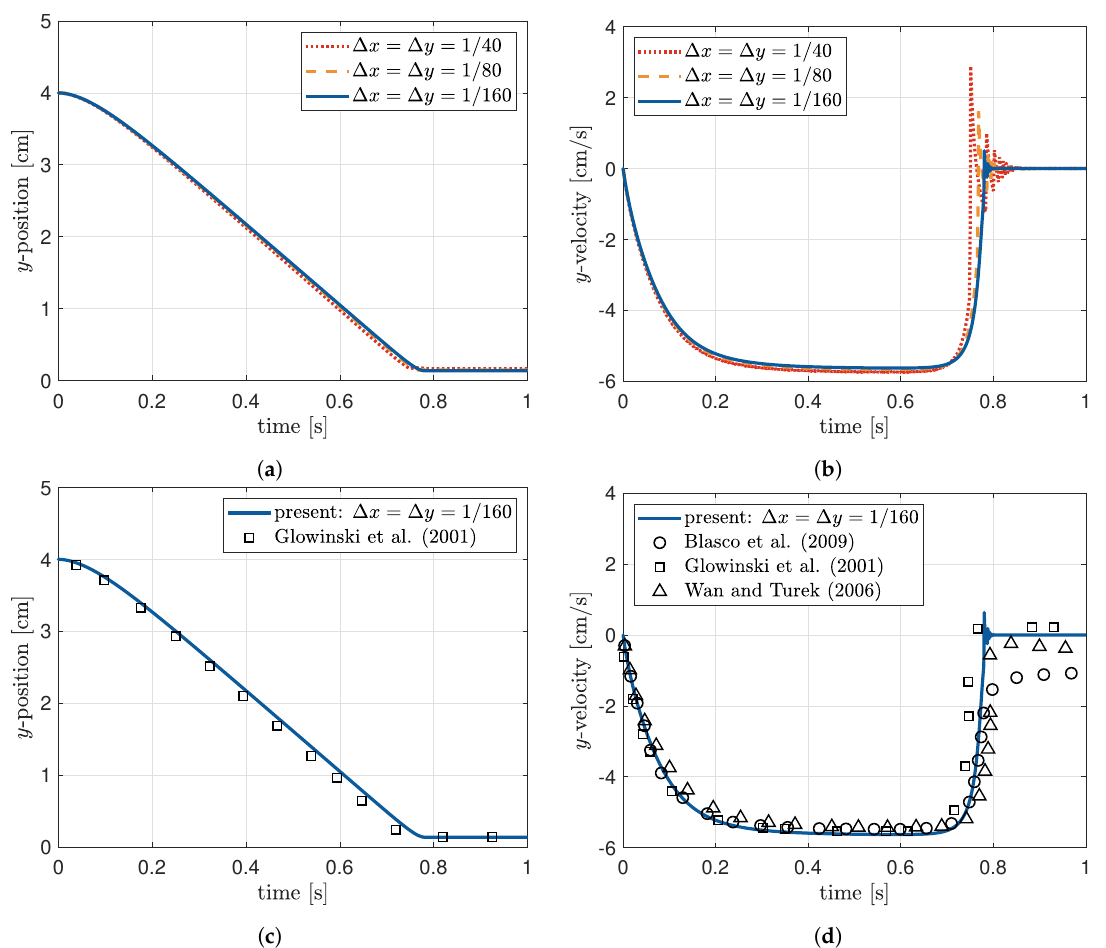
Figure 3. Time traces of ( a ) y -position and ( b ) y -velocity of circular disk showing grid independence. Time traces of ( c ) y -position and ( d ) y -velocity of circular disk compared with Reference